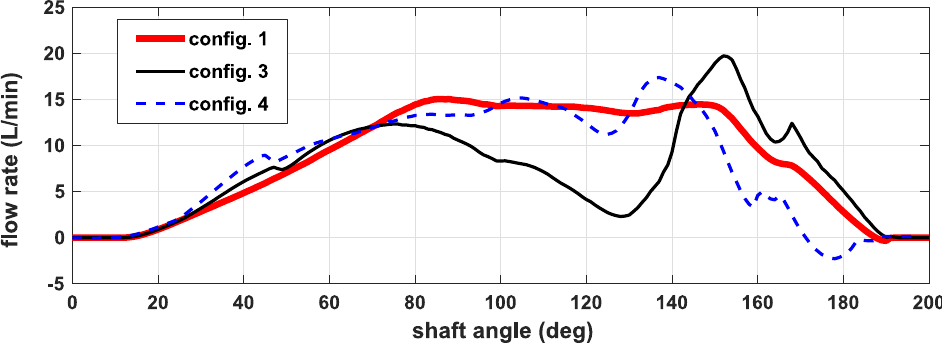
Figure 7. Total instantaneous flow rate entering a chamber (positive if ingoing) as a function of the shaft angle for three different configurations.